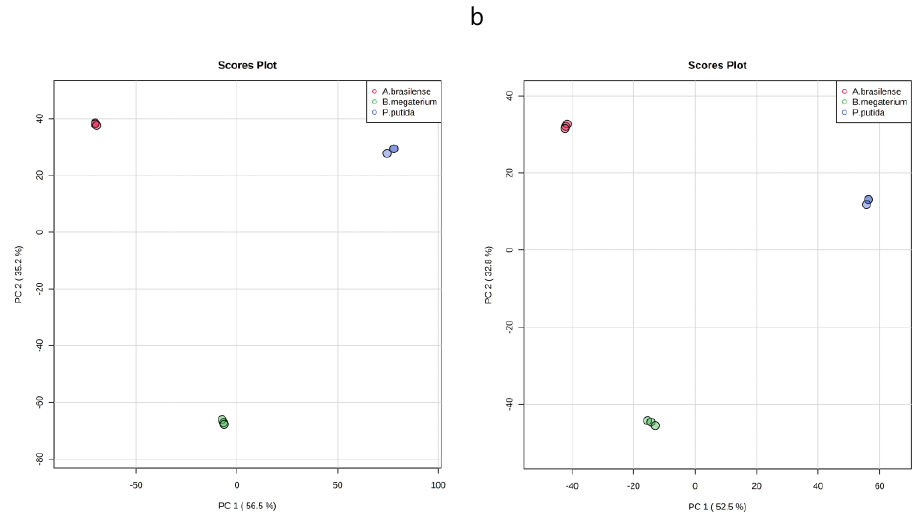
Figure 1. PCA models of negative and positive polarities. ( a ), PCA plot of data set in negative mode; ( b ), PCA plot of data set in positive mode .